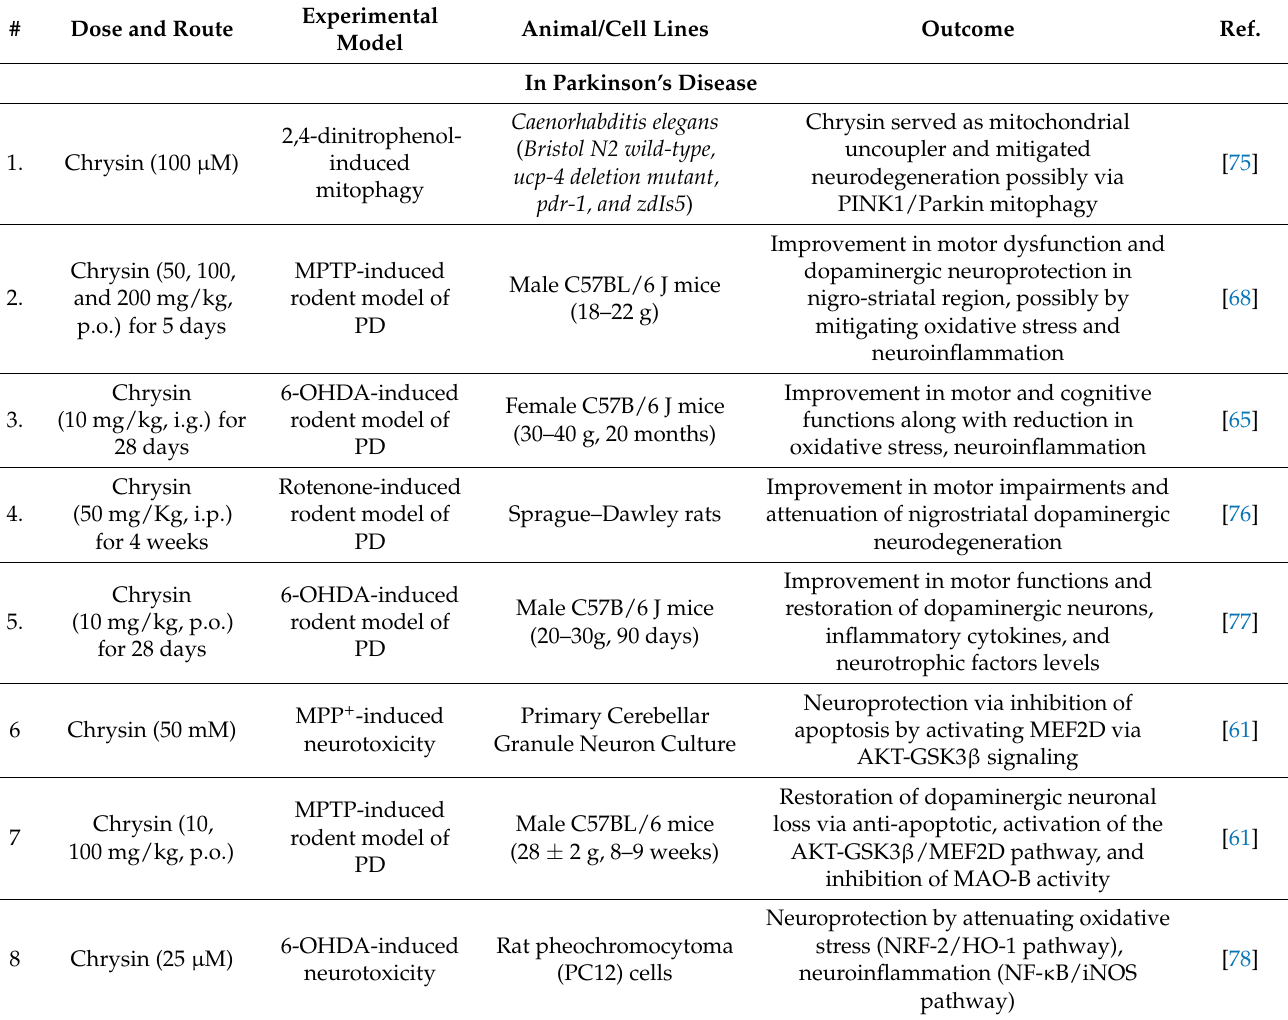
Table 1. Experimental evidence supporting the neuroprotective role of chrysin in various neurological disorders. Experimental # Dose and Route Animal/Cell Lines Outcome Model